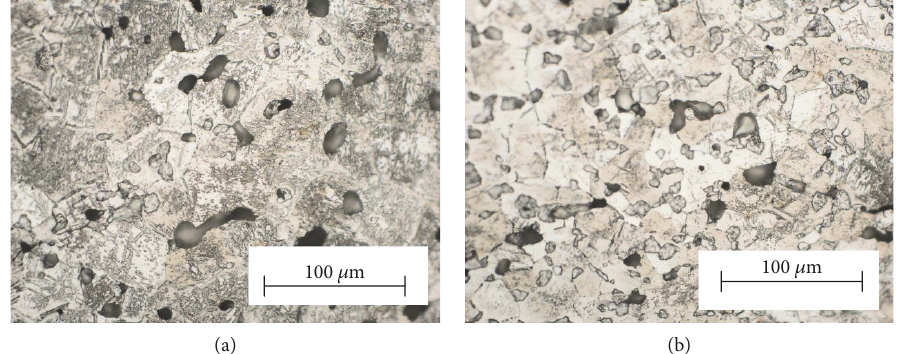
Figure 3: Microstructure of thermally sintered Ti part prior to laser sintering (a) polished external surface and (b) sectioned and polished internal